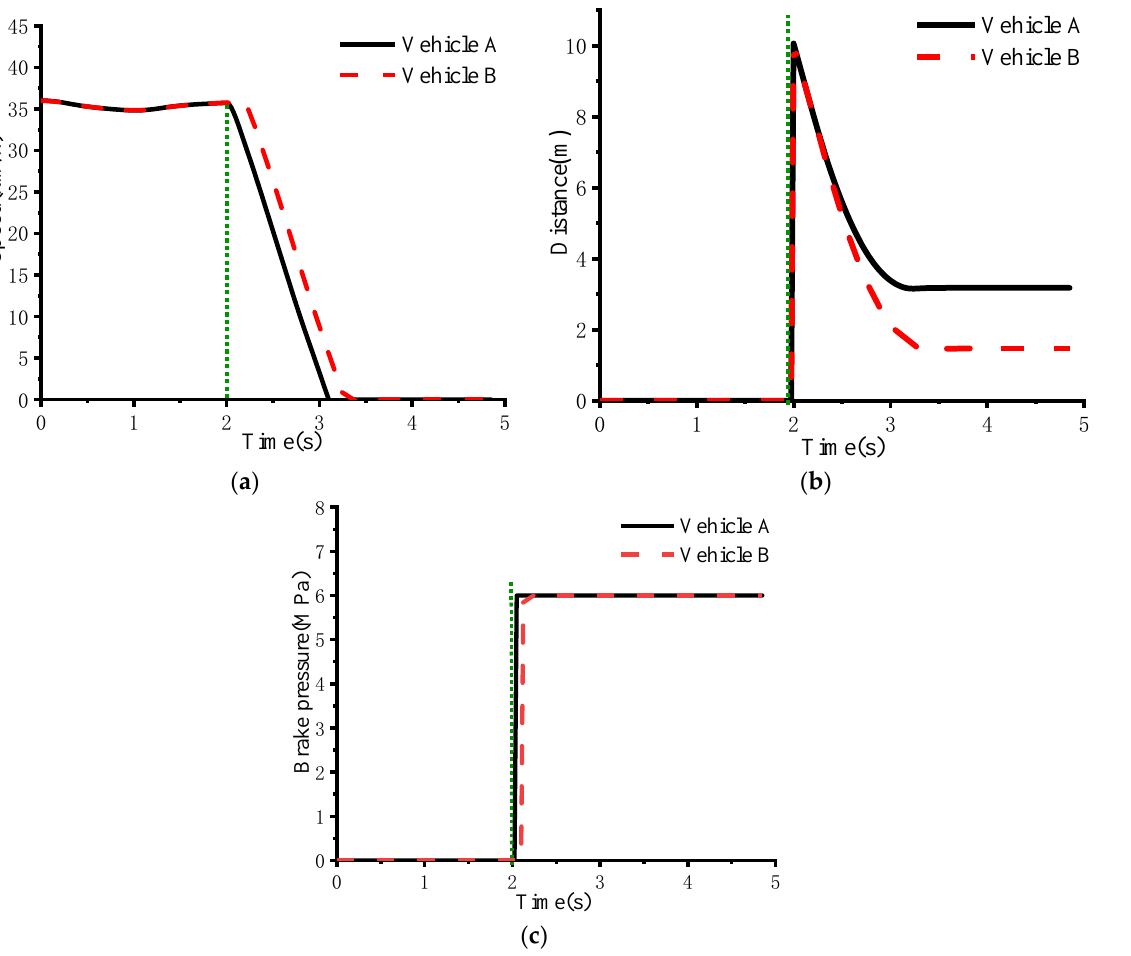
Figure 8. Simulation of longitudinal collision avoidance: ( a ) Vehicle speed; ( b ) Distance between vehicle and obstacle; ( c ) Brake pressure of the vehicles.